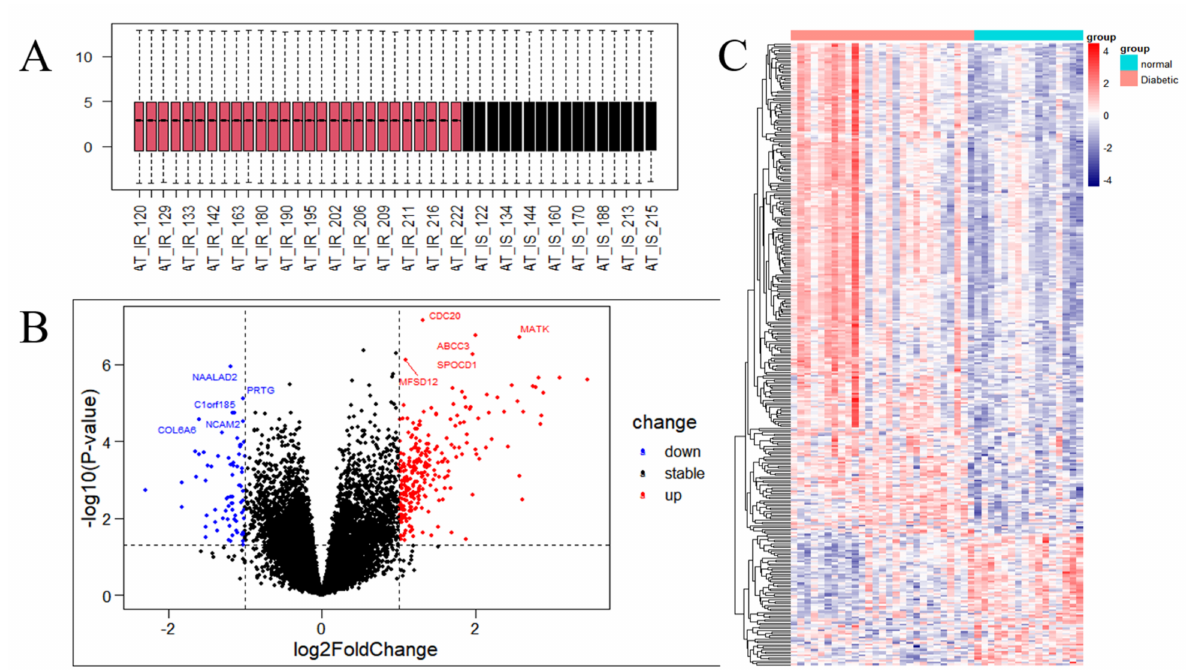
Figure 2. Analysis of the gene expression correlation and differential gene expression between the insulin resistance (IR) and control groups in the dataset. ( A ) Box plot of the gene probe expression levels among the samples. There was no significant difference in the median or upper and lower quartiles. ( B ) Volcano map of all differentially expressed genes (DEGs) in the IR and control groups analyzed with the limma R package; p < 0.05 and |log2 fold change| ≥ 1. The top 10 upregulated and downregulated genes with the smallest p -values are marked on the map. ( C ) Heatmap of all DEGs in the IR and control